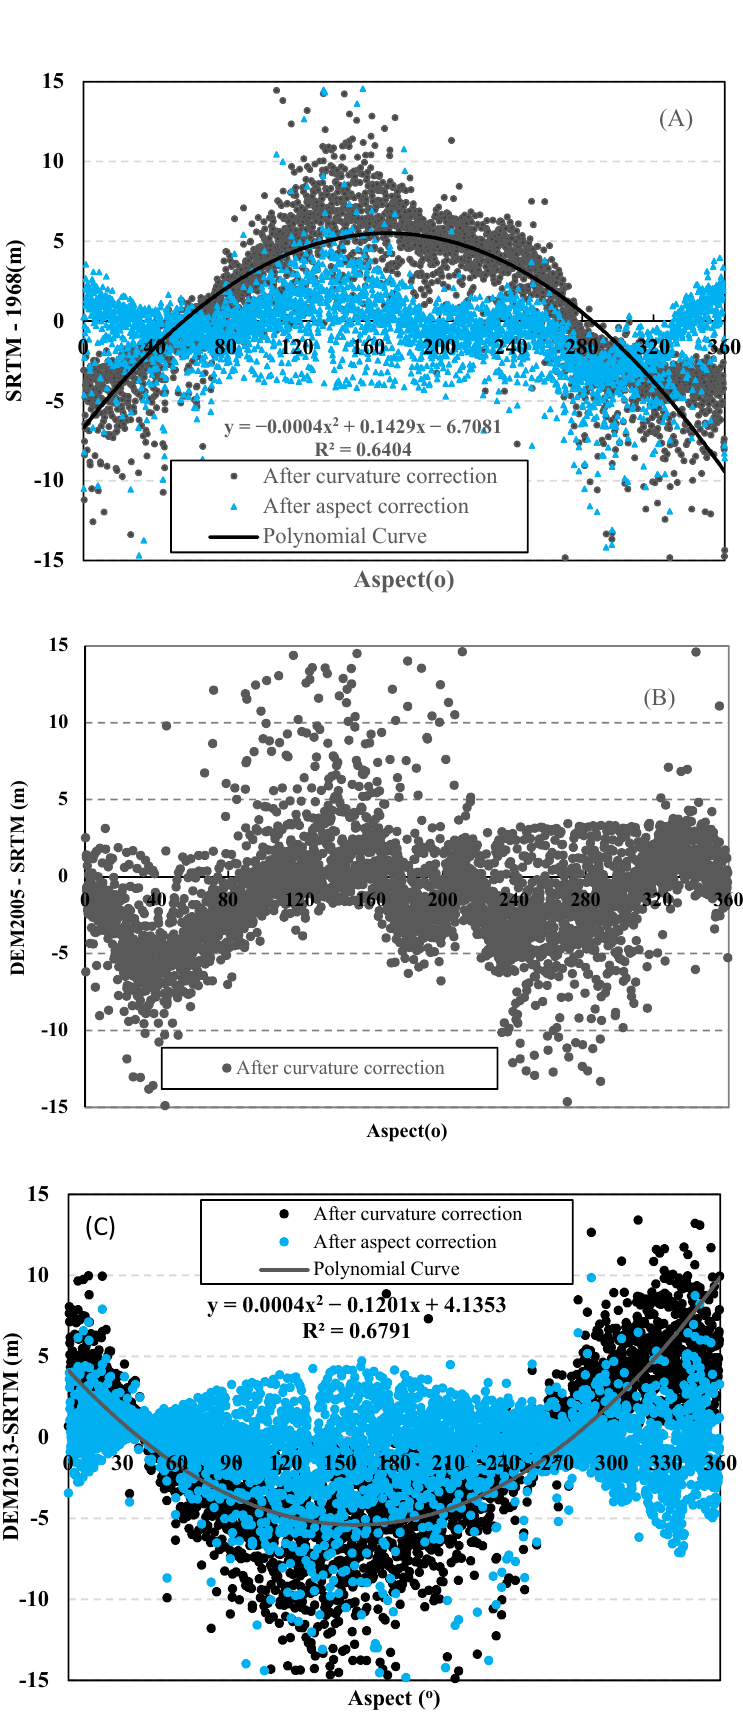
Figure 6. The elevation differences between DEM1968, DEM2005 and DEM2013 and SRTM as a function of aspect over the ice-free area. ( A ) SRTM–DEM1968, ( B ) DEM2005–SRTM and ( C ) DEM2013–SRTM.